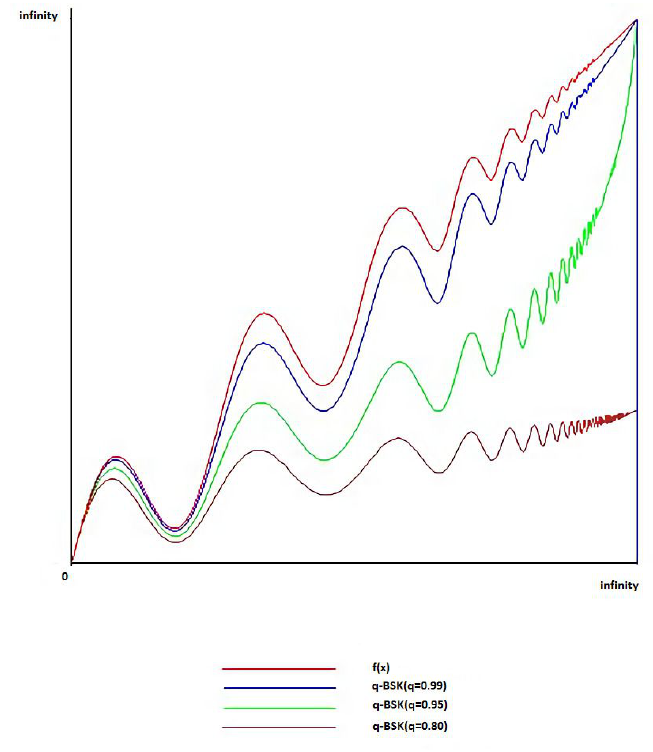
Figure 2: The convergence of the operators ˜ R 50 ( f ; q , x ) to f ( x ) for increasing values of q